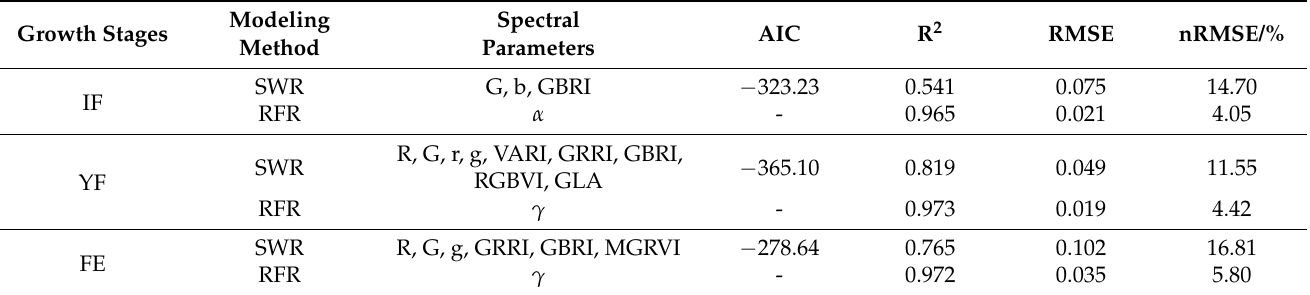
Table 6. Comparison of SWR and RFR analyses for spectral parameters in each growth stage.